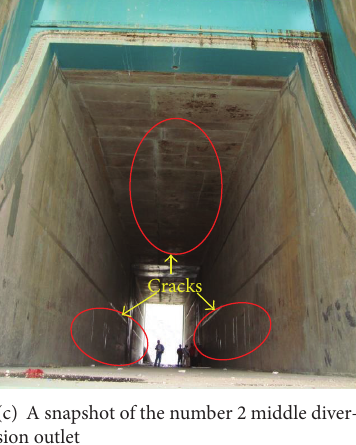
Figure 4: Cracking near the middle diversion outlets of the Xiaowan arch